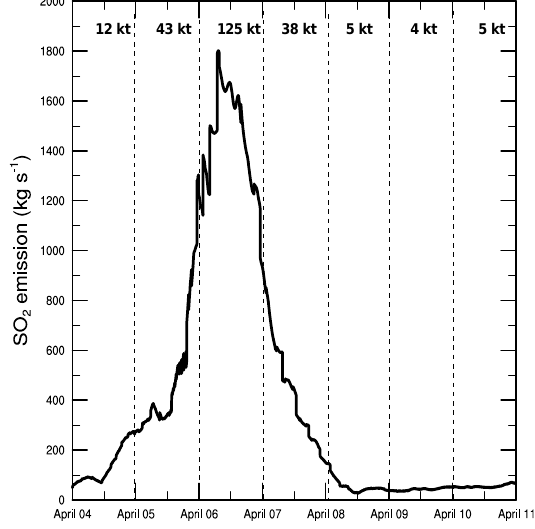
Fig.9. EvolutionoftheSO 2 emission( kg.s − 1 )estimatedbyMesoNHbetweenApril4andApril11,2007.Valuesalongthetopcorrespond Fig. 9. Evolution of the SO 2 emission (kgs − 1 ) estimated by todailymassofSO 2 (kt)emittedduringtheperiod. MesoNH between 4 April and 11 April 2007. Values along the top correspond to daily mass of SO 2 (kt) emitted during the